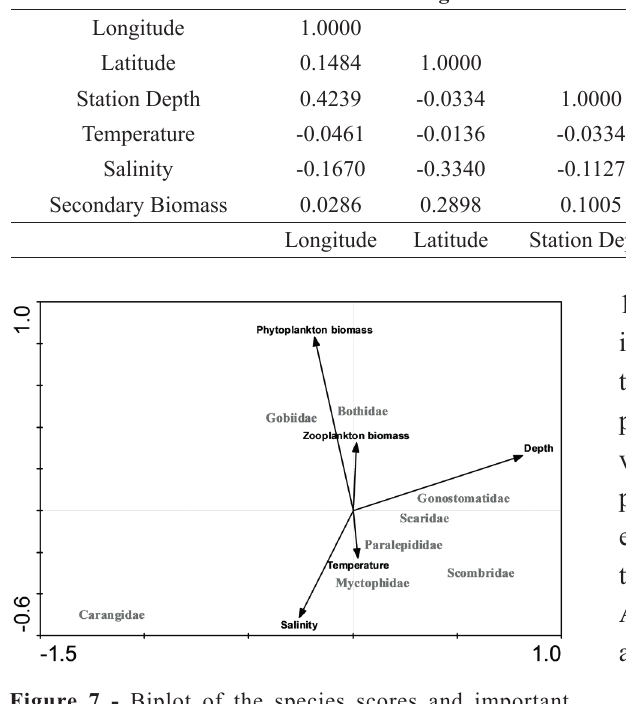
Figure 7 - Biplot of the species scores and important environmental correlation vectors in the first two canonical correspondence analysis